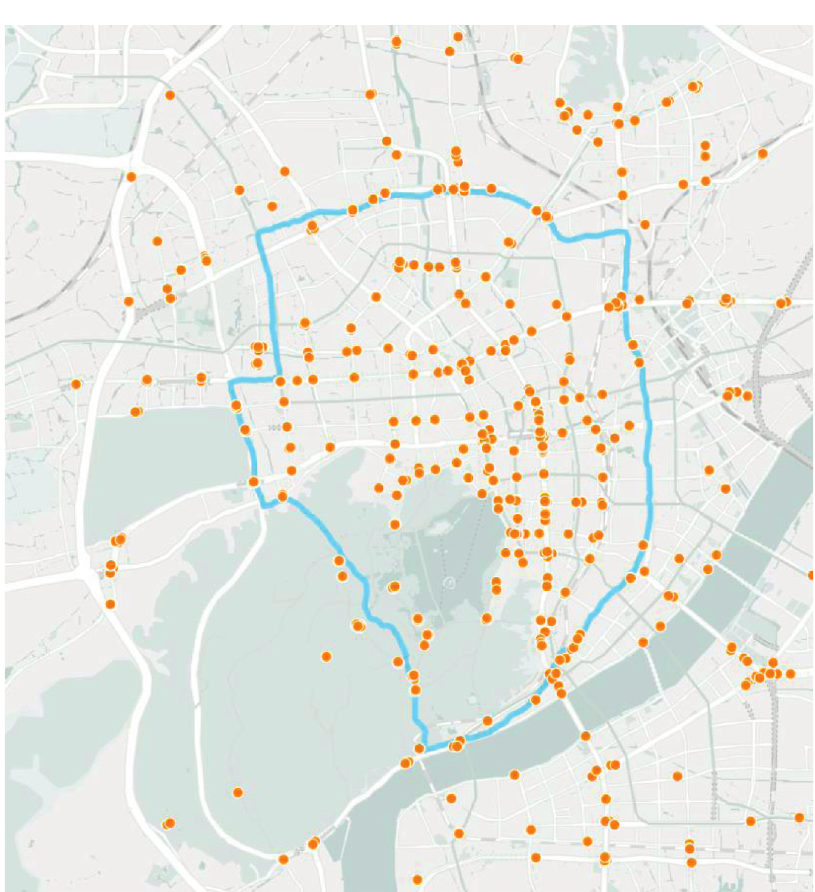
Figure 1: Distribution of cameras. The blue line frames the urban area of Hangzhou.